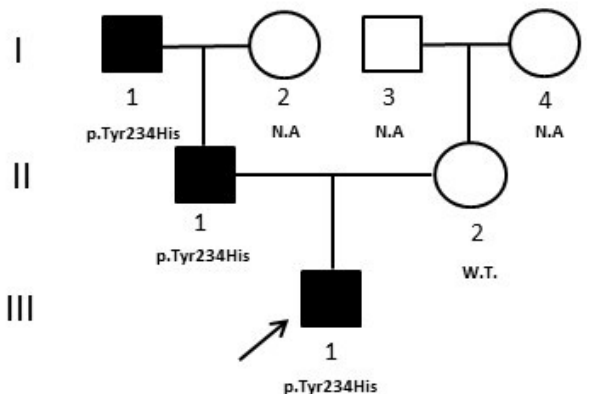
Figure 2. Case 2 pedigree. The pedigree shows the segregation of the GCK variant detected in the proband. Filled symbols indicate subjects with diabetes. W.T.= Wild type. N.A.= not analyzed. ↗ = proband.